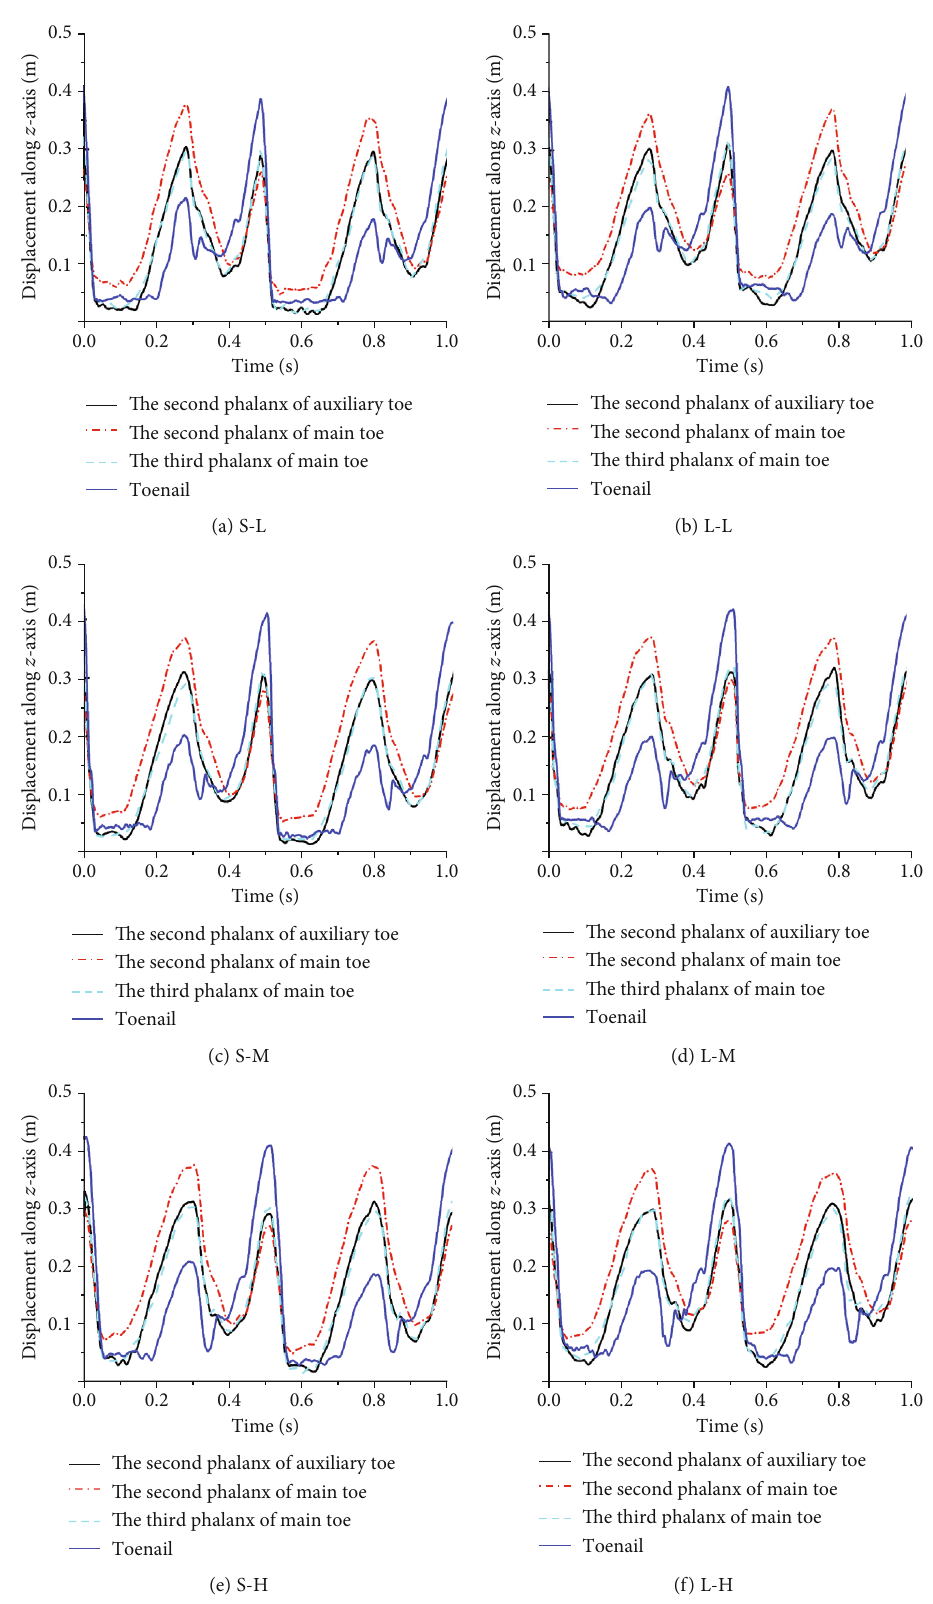
Figure 10: The displacement curve of the phalanges along the z -axis. (a – f) The displacement changes of each phalanx along the z -axis under six working